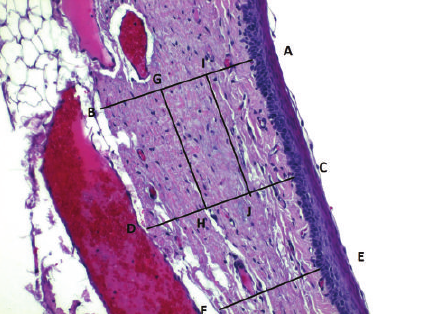
Figure 8: Schematic overview of lamina propria thickness. Lines AB, CD, and EF represent three different points for the calculation of the median. Measurements were performed in mm. Lines GH and IJ represent the division of the lamina propria in three equal- in-thickness layers, SLP, ILP, and